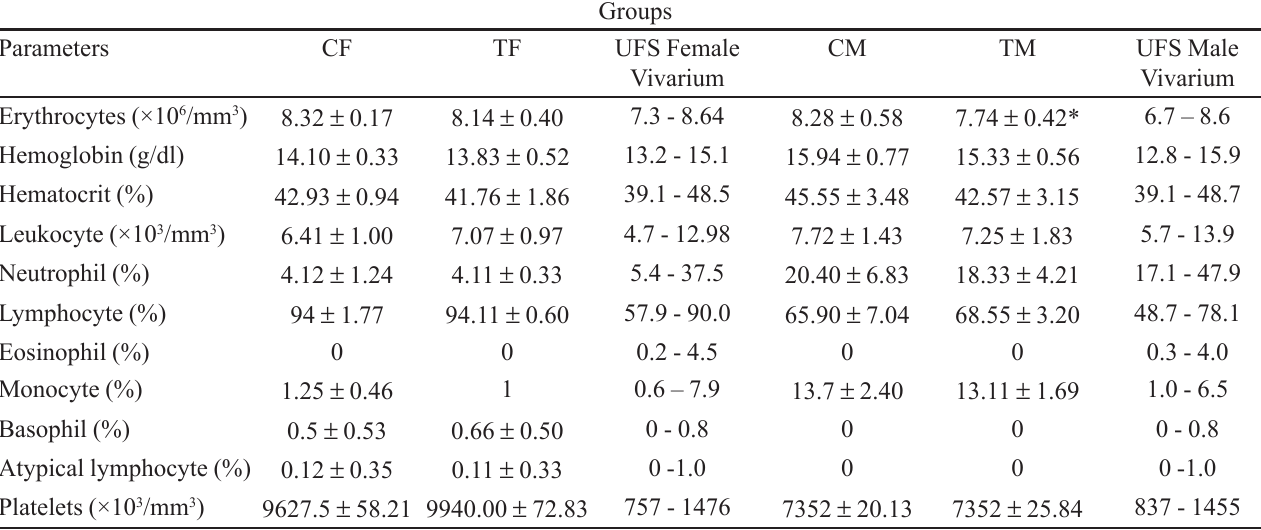
TABLE III - Effect of 30-day oral administration of atranorin (ATR) on hematological parameters, considering sex interaction, in Wistar rats (n =